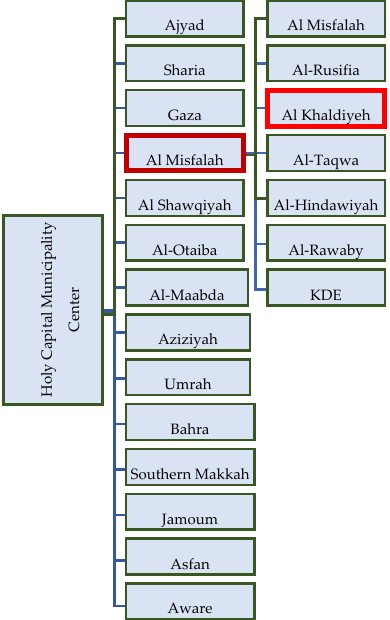
Figure 9. Waste management system distribution.